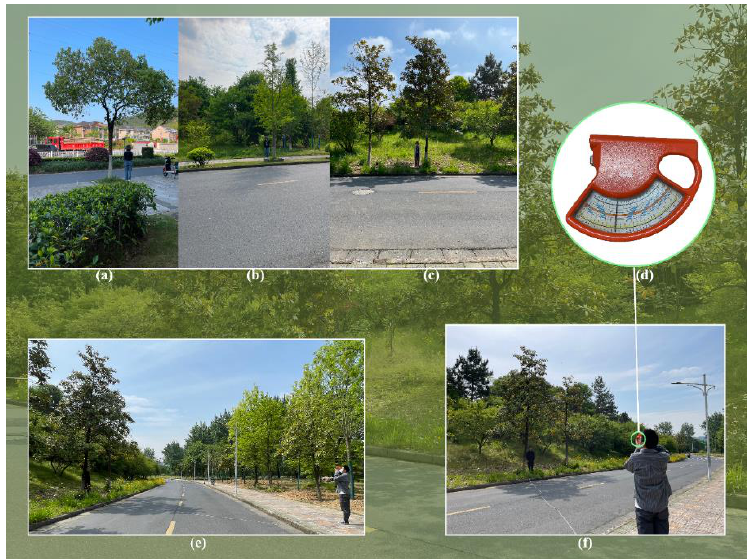
Figure 2. Traditional field survey. ( a )-( c ) CC, GB, and YD trees to be measured. ( d ) Blume – Leiss gauge. ( e ) and ( f ) Measuring the tree heights using the Blume – Leiss gauge. LabelImg software was used to label the images in the training set in YOLO format with “ person ” and “ tree ” categories. LabelImg generated a text file with the same name corresponding to each image when the labeling was completed. Finally, the label category, the ratio of the horizontal coordinate of the center of the label box to the width of the image, the ratio of the vertical coordinate of the center of the label box to the height of the image, the ratio of the width of the label box to the width of the image, and the ratio of the height of the label box to the height of the image were saved. The images obtained before and after labeling are shown in Figure 3.